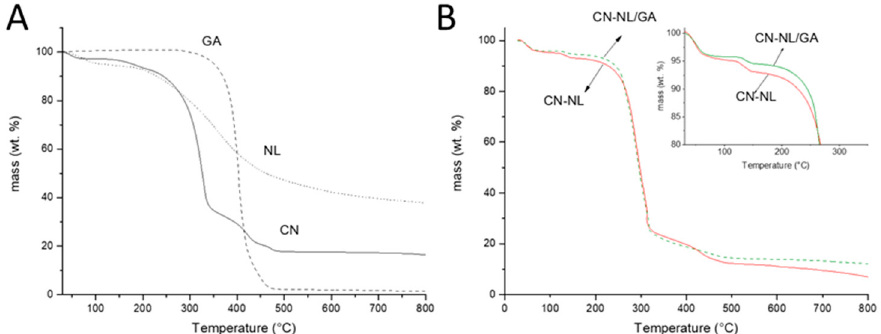
Table 1. Results of TGA analysis.